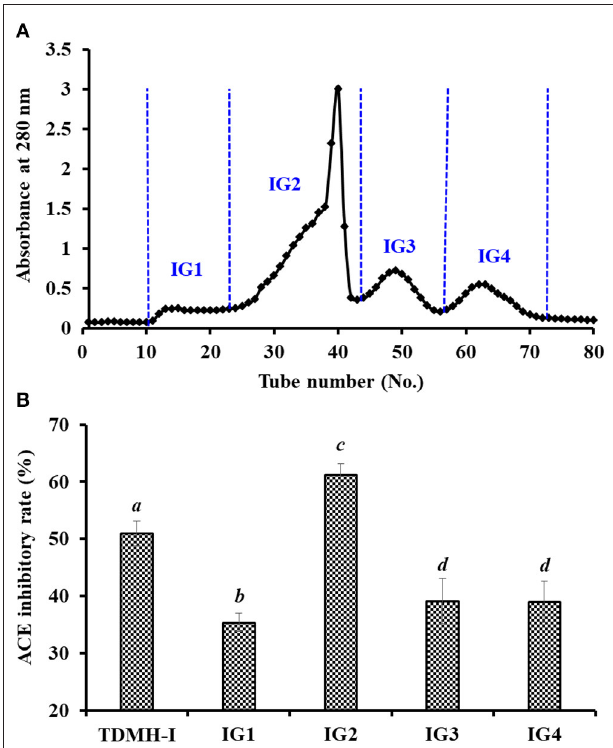
FIGURE 4 | Chromatogram profiles of TDH-I isolated by Sephadex G-25 (A) and ACEi rates of prepared peptide fractions (IG1-IG4) from TDH-I at the concentration of 0.5mg protein/mL (B) . a − d Values with same letters indicate no significant difference ( P >